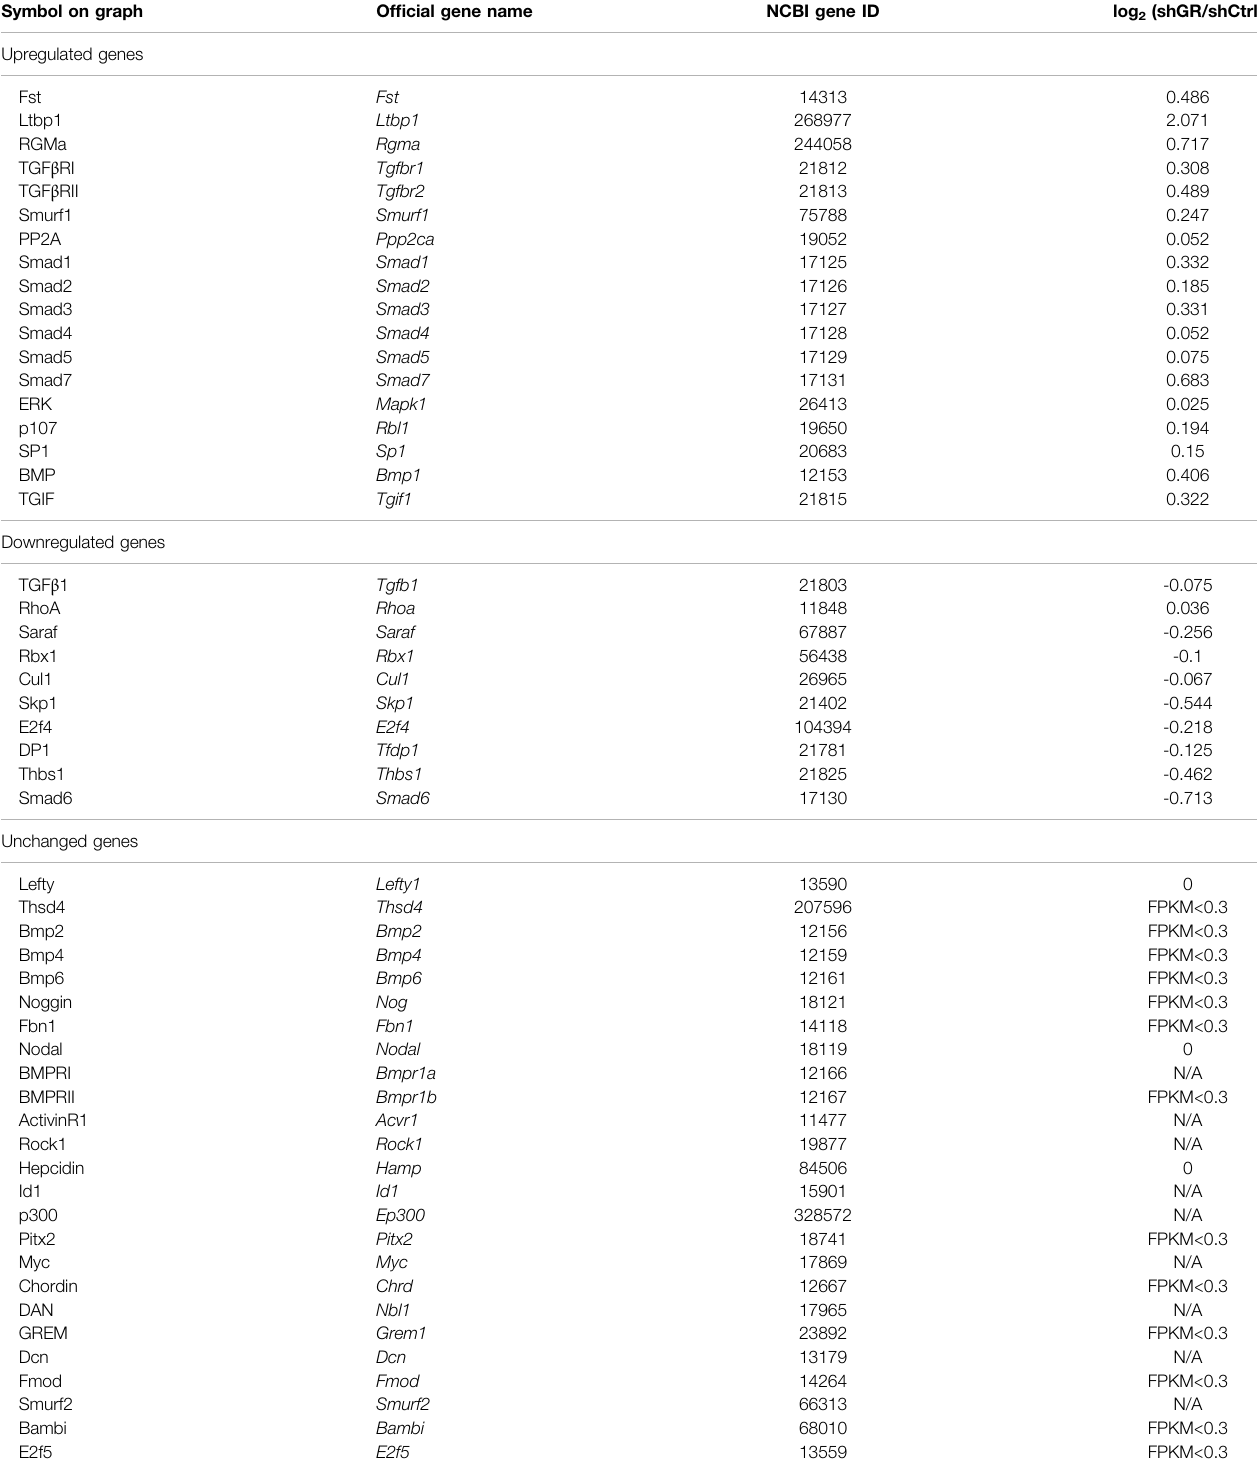
TABLE 7 | “ TGF β signaling pathway ” gene table. Symbol on